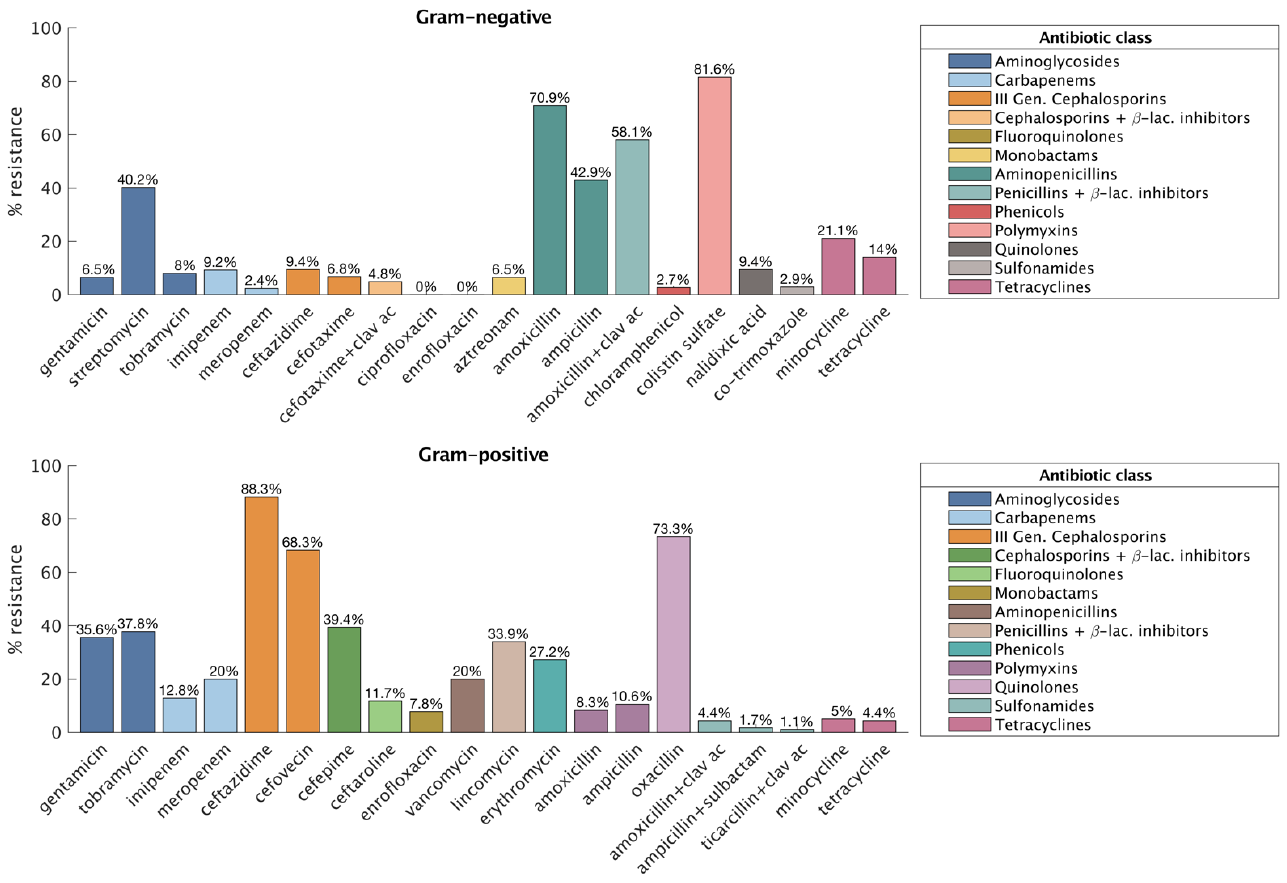
Figure 1. Percentage of gram-negative (upper panel) and gram-positive (lower panel) strains resistant to specific molecules.